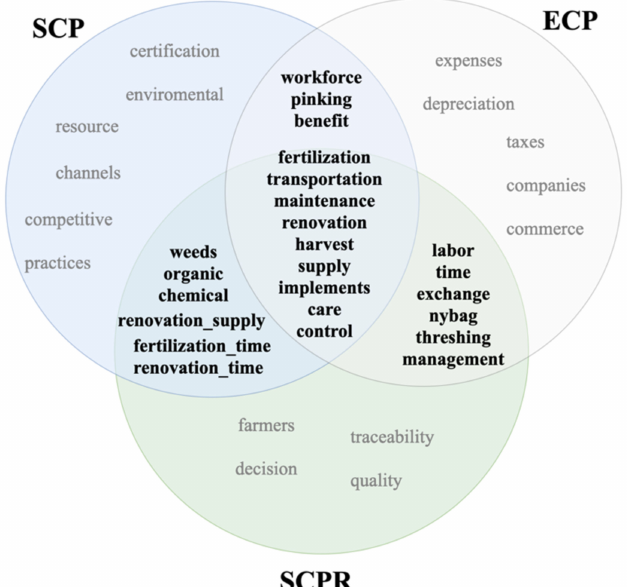
Figure 5. Venn diagram of the identified concepts. The colors blue, grey, and green represent the regions by query strings Small-scale Coffee Production (SCP), Economic Coffee Profitability (ECP), and Small-scale Coffee Profitability (SCPR) region 25 words. The 24 words located in the overlap regions are selected as HMP-Coffee brainstorming (words in